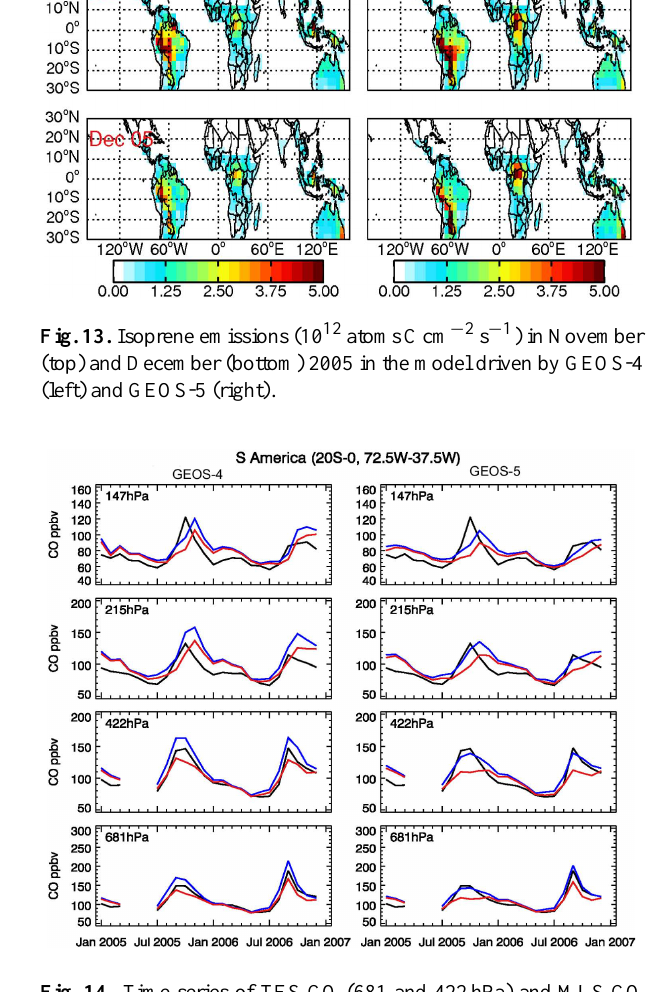
Fig. 14. Time series of TES CO (681 and 422hPa) and MLS CO (215 and 147hPa, scaled as in Fig. 8) (black) with (left) GEOS- 4, (right) GEOS-5 model results over South America. The standard simulation is in red, and the simulation with adjusted emissions (see text) is in